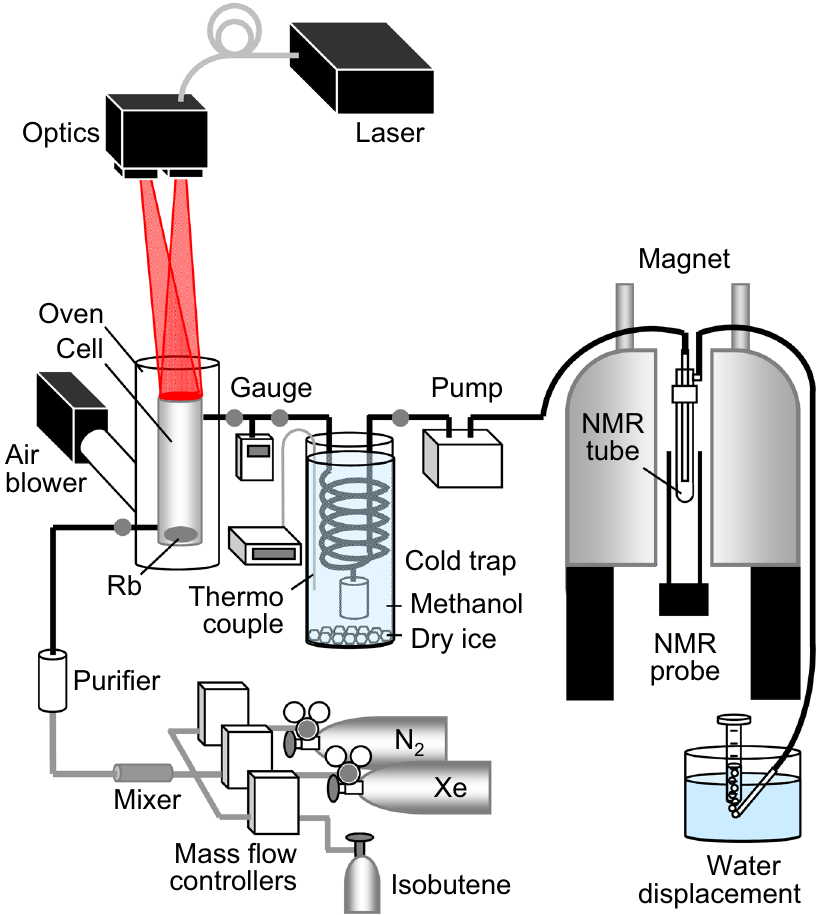
Figure 4. Schematic diagram of the experimental setup. Details are given in the